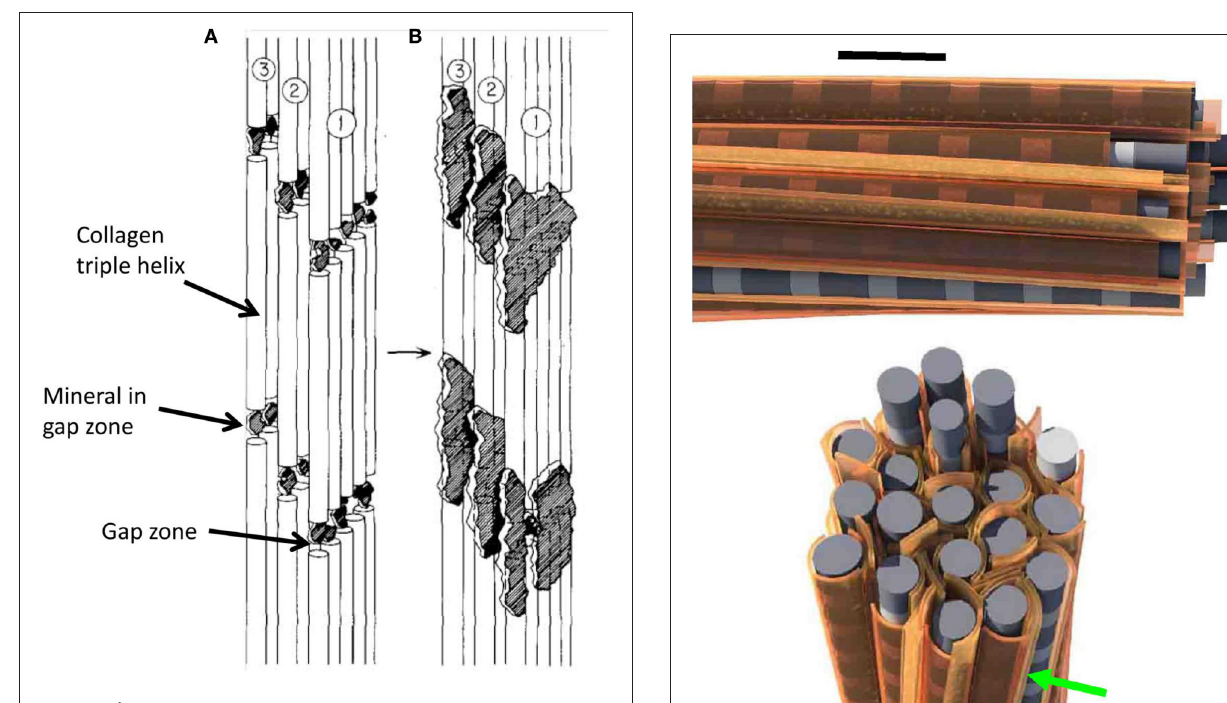
FIGURE 7 | Schematic diagram showing progressive steps in mineralization of collagen molecules in a single fibril, assuming that most mineral in bone is intrafibrillar. (A) is earlier stage of mineralization with all mineral in gap zone; in (B) , further mineralization extends into adjacent overlap zones. From Landis et al. [27].